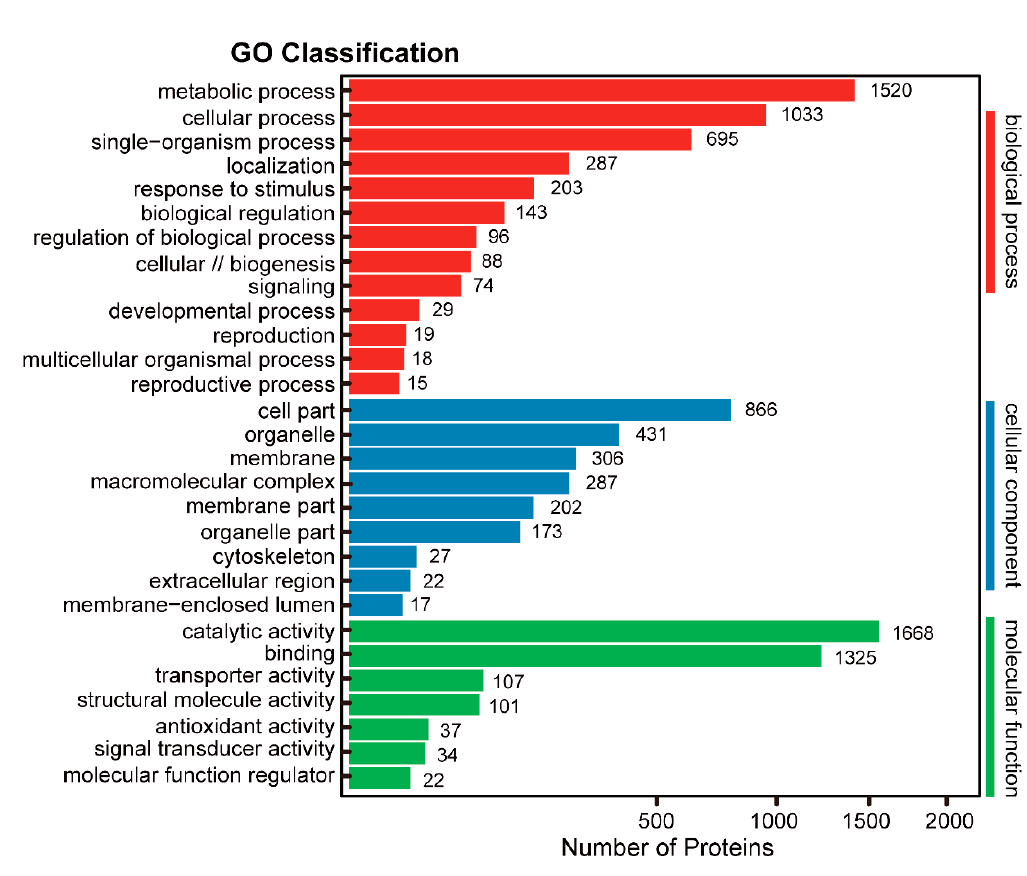
Figure 5. GO classification of the identified proteins. The 3592 proteins identified from the 6M roots by both shotgun and 2-DE methods were performed GO analysis and these proteins were classified into 3 main categories including biological process, cellular component and molecular function. The number of proteins denotes those with GO annotations.